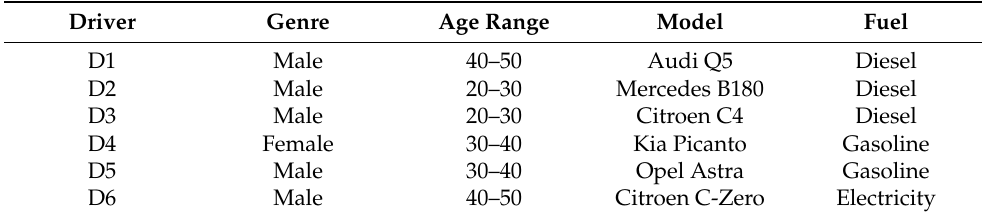
Table 2. Drivers and vehicles in the UAH dataset